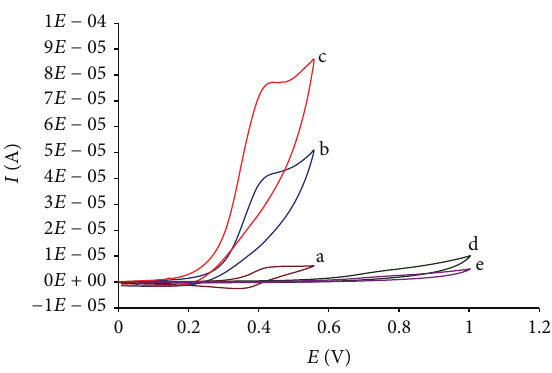
Figure 1: TEM image of NiO nanoparticles. Figure 2: Cyclic voltammograms of (a) the buffer solution at FCAD/NiO/NPs/CPE; (b) 1.0 mM cysteamine at FCAD/CPE; (c) 1.0 mMcysteamineatFCAD/NiO/NPs/CPE;(d)1.0mMcysteamine at NiO/NPs/CPE; and (e) 1.0 mM cysteamine at CPE. Conditions: 0.1 molL −1 PBS (pH 7.0), scan rate of 20 mVs −1